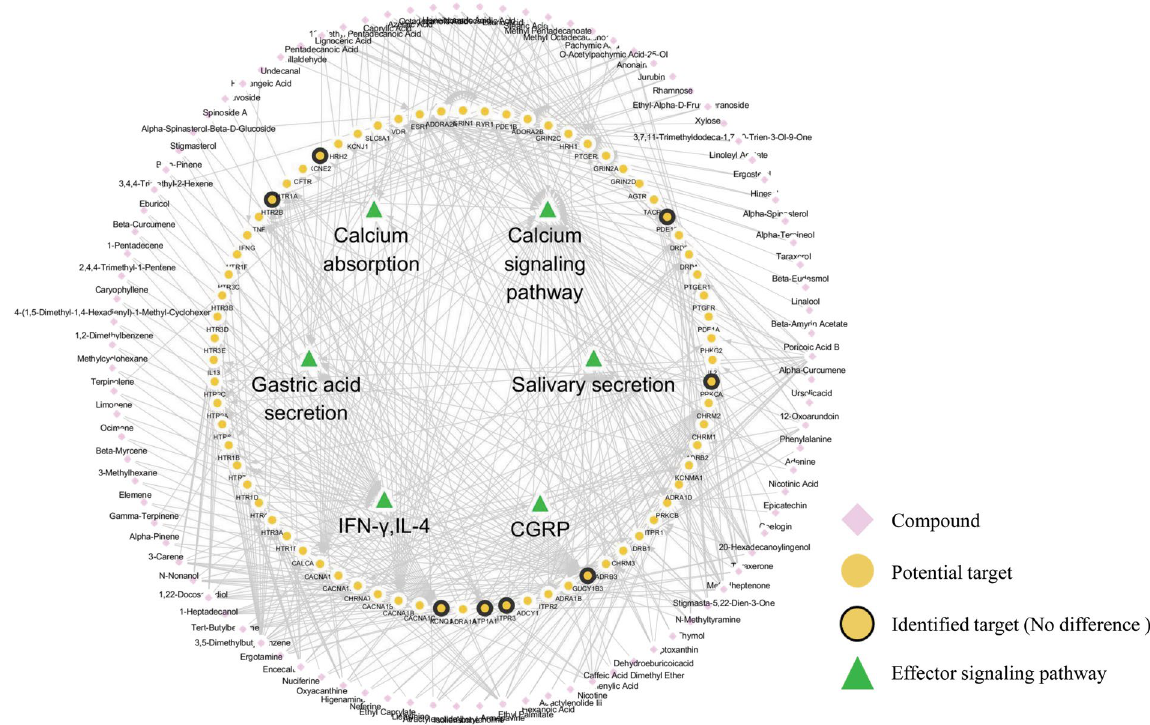
Figure 5. Network of interactions among the chemical components of XEFP, effector molecules regulated by XEFP against FD, potential protein targets, and related pathways in which these genes are